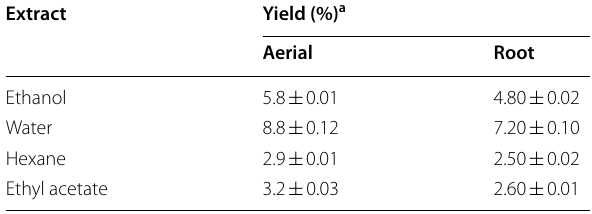
Table 3 Extractive yield analysis